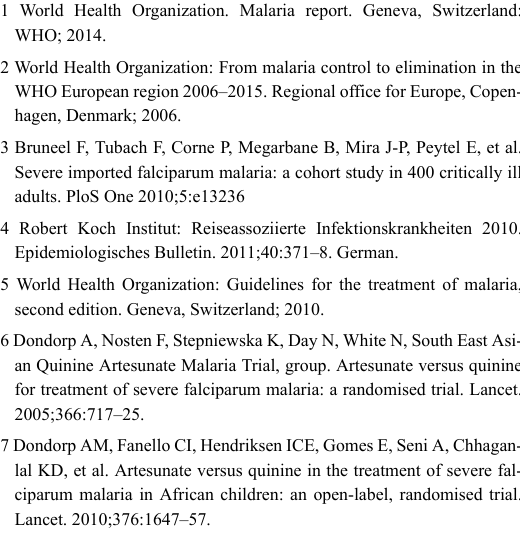
Table 1: Laboratory test results for the four patients with post artesunate delayed hemolysis. Age/ Blood Cumulative dose of IV sex smear artesunate Case 1 32/F 27.5% Case 2 41/F 9%